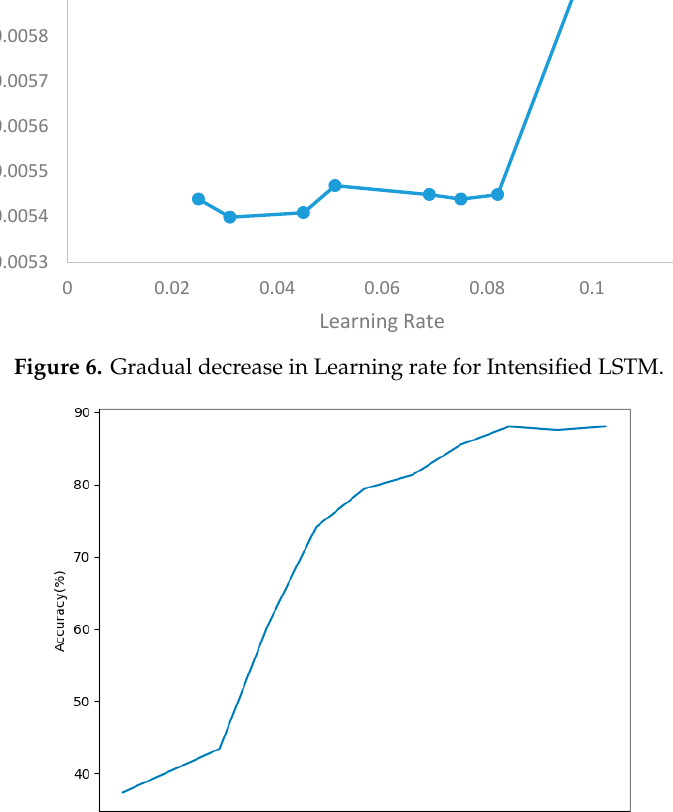
Figure 6. Gradual decrease in Learning rate for Intensified LSTM.